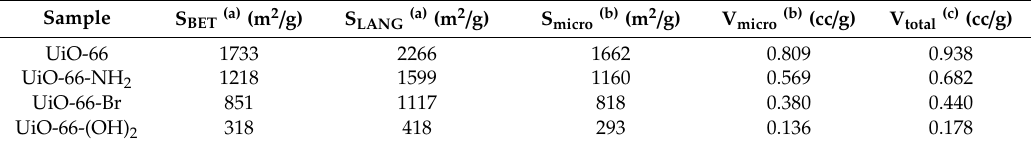
Figure 3. (a) Powdered X-ray diffraction (PXRD) pattern; (b) N 2 adsorption–desorption isotherms at 77 K (open and closed symbols describe the adsorption and desorption isotherms); (c) FTIR curves; (d) thermogravimetric curves of UiO-66 and its derivatives. Table 1. Surface areas and pore volumes of UiO-66 and its derivatives, determined by N 2 physisorption at 77 K.